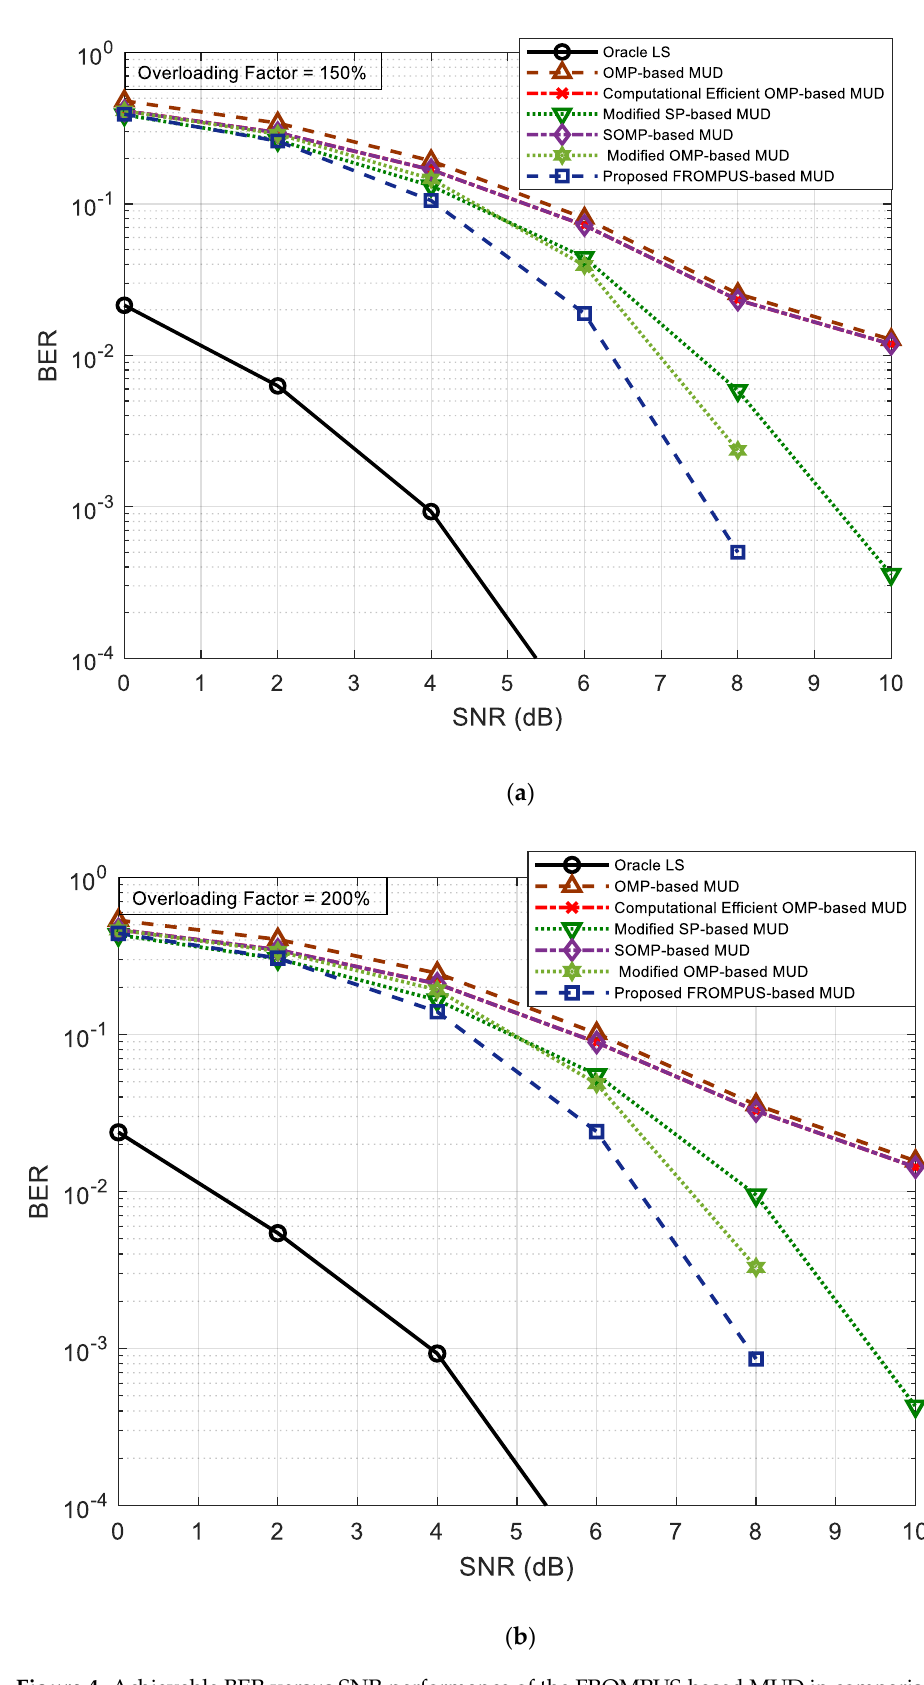
Figure 4. Achievable BER versus SNR performance of the FROMPUS-based MUD in comparison with five other MUDs, (cid:61) = 20, and T = 7: ( a ) overloading factor = 150%; ( b ) overloading factor =